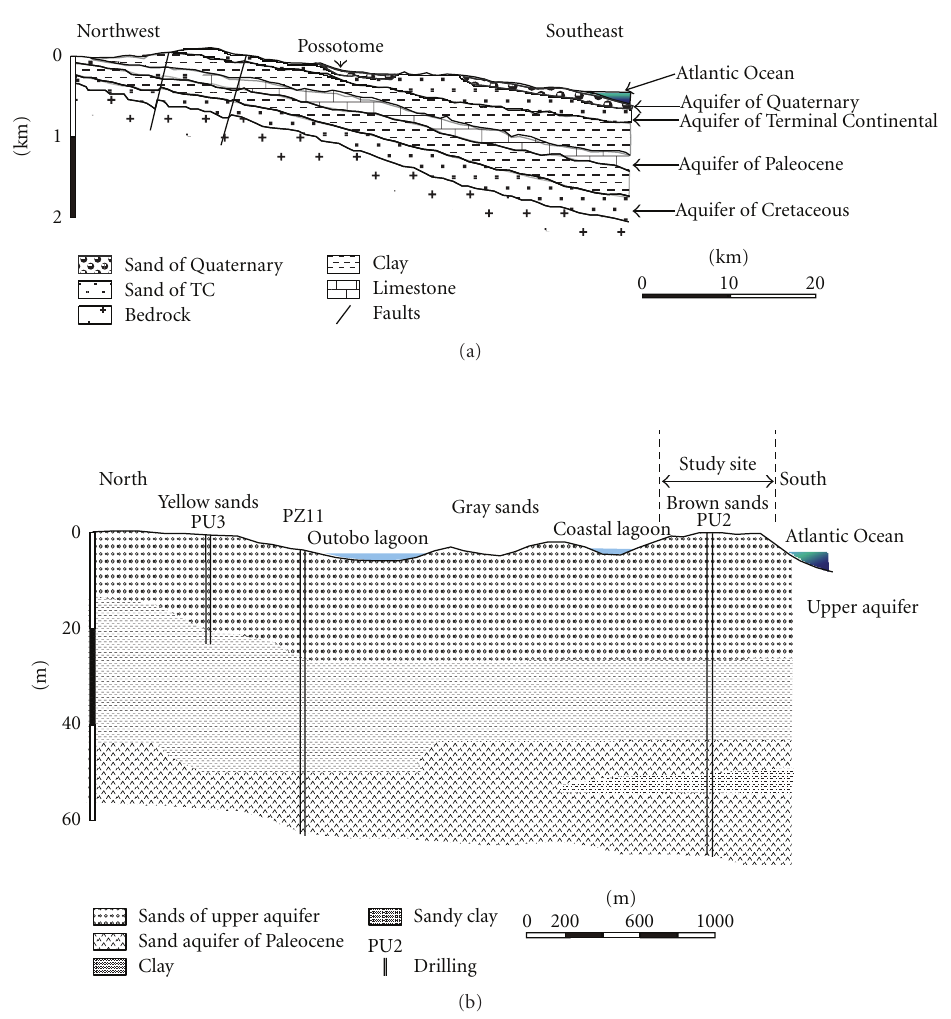
Figure 3: (a) Hydrogeological section of littoral plain. (b) Hydrogeological section of upper